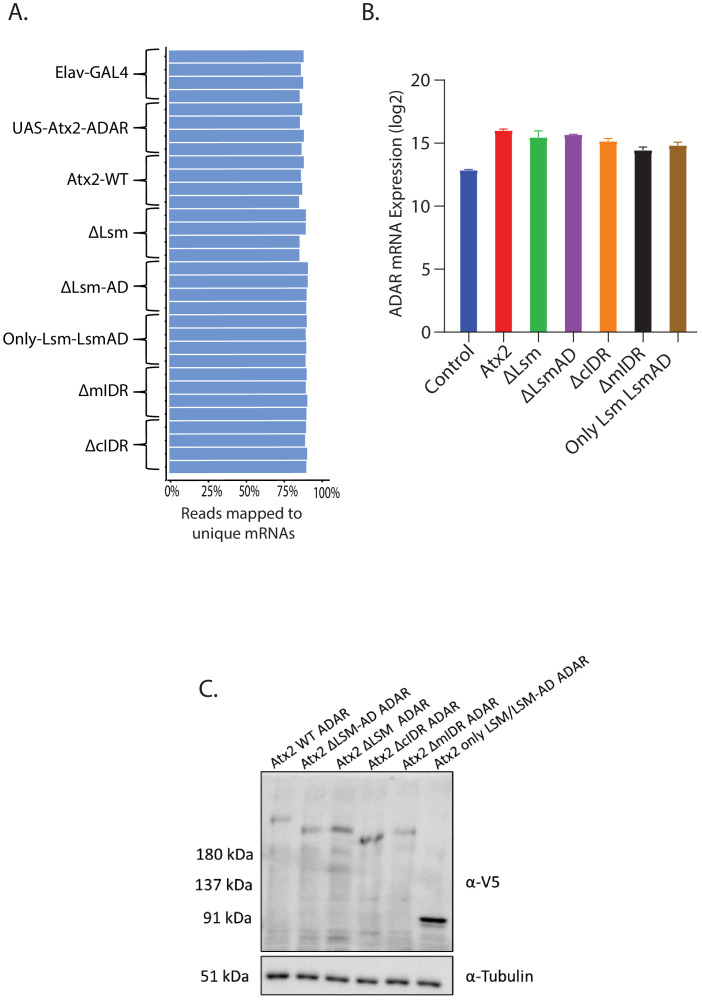
Equivalent read quality and ADAR expression across Atx2 deletion analyses.Poly(A)-enriched mRNA from 10 to 12 brains was sequenced using paired-end libraries on Illumina 2500. (A) The reads obtained were comparable between genotypes and of high quality, and mapping to the Drosophila genome was >80% for all the samples (Figure 4—figure supplement 1—source data 1). (B) Quantification for ADAR mRNA as a read out for transgene expression showed expression above the endogenous control and comparable between Atx2 WT and the various mutant transgenic lines. (C) Western blots with anti-V5 antibody show levels of Atx2 transgene expression in Drosophila brain among transgenic lines.